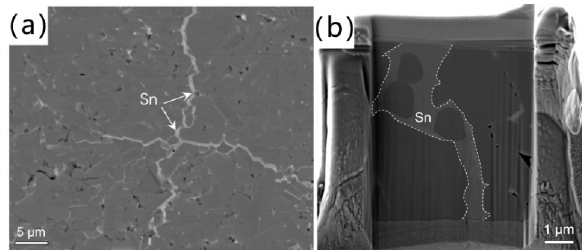
Fig. 7 (a) Back-scattered SEM image of polished surface of Ti 2 SnC after healing at 800 for 1 h at a low ℃ oxygen partial pressure of 5 Pa. Cracks were filled with only metallic Sn. (b) Observation of the healed zones made by focused ion beam (FIB). The healed zone is filled with Sn marked by dashed lines. Reproduced with permission from Ref. [89], © Elsevier Ltd and Techna Group S.r.I. 2017.